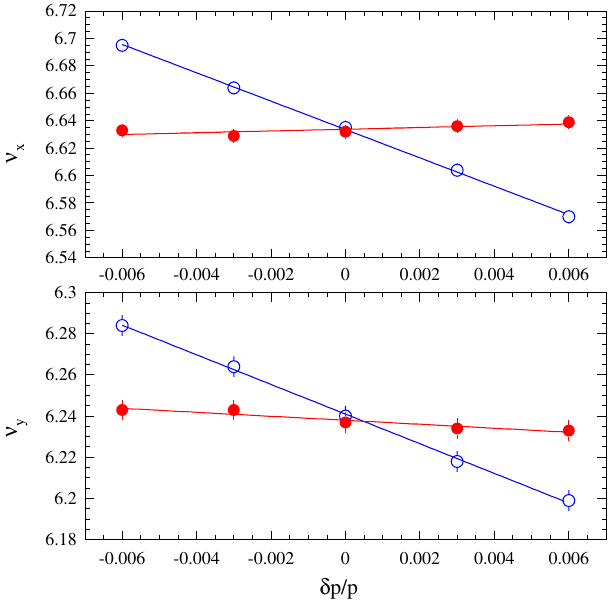
FIG. 9. (Color) Horizontal (upper) and vertical (lower) betatron tunes as a function of the momentum offset measured in the beam storage mode before (open blue circles) and after (closed red circles) the chromaticity correction.